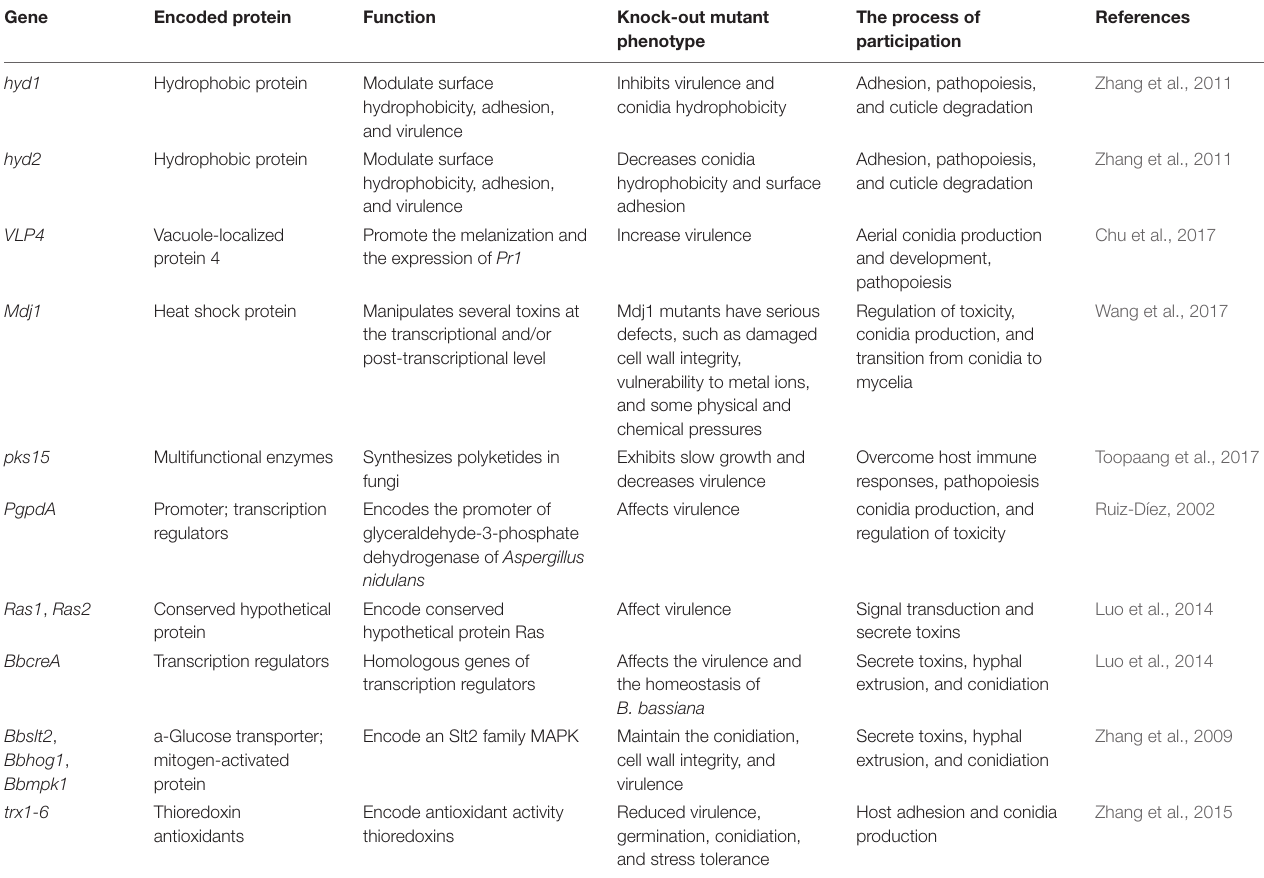
TABLE 1 | Underlying genetic and molecular mechanisms of fungal